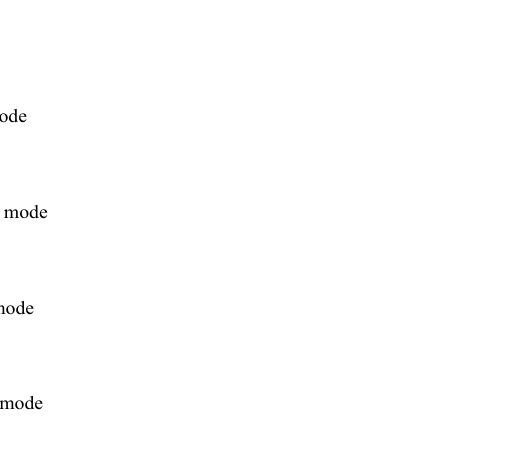
Figure 9. The first 4 order modal shapes and measuring points